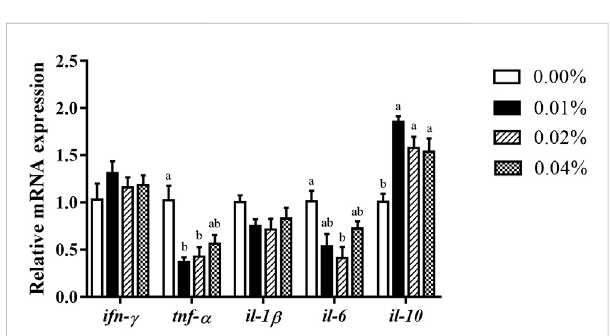
FIGURE 5 Effects of supplemental fulvic acid on genes related to in fl ammation mRNA expression in liver of large yellow croaker larvae (mean±S.E.M,n=3). Ifn- γ ,interferon γ ; tnf- α ,tumornecrosisfactor α ; il-1 β , interleukin-1 β ; il-6 , interleukin-6; il-10 , interleukin-10. Bars with different letters showed a signi fi cant difference ( p < 0.05, Tukey ’ s